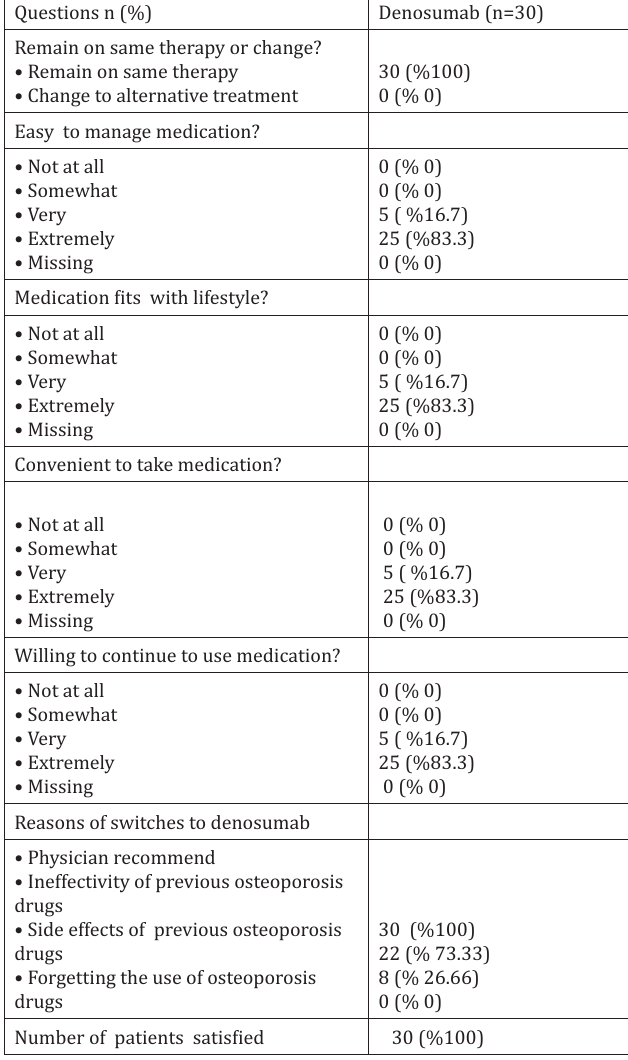
Therapy preference and